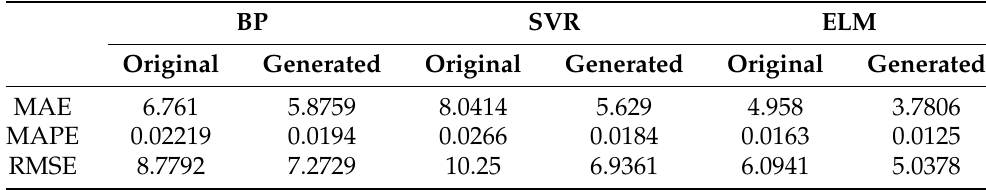
Table 1. Comparison of setting errors of grinding ore feeding.